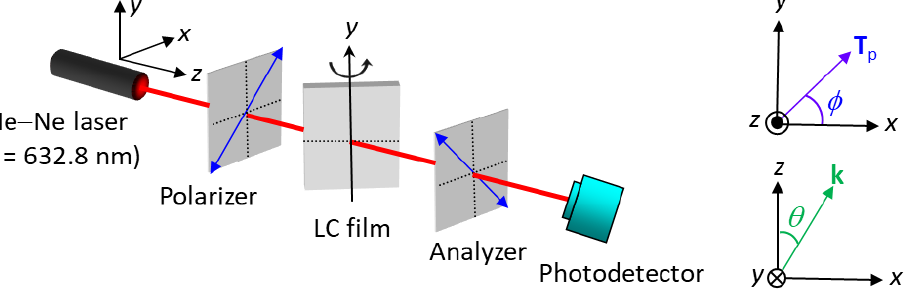
Figure 1. Schematic of the optical setup with crossed polarizers for the measurement of the thickness of LC films spin-coated on a DMOAP-coated glass substrate.